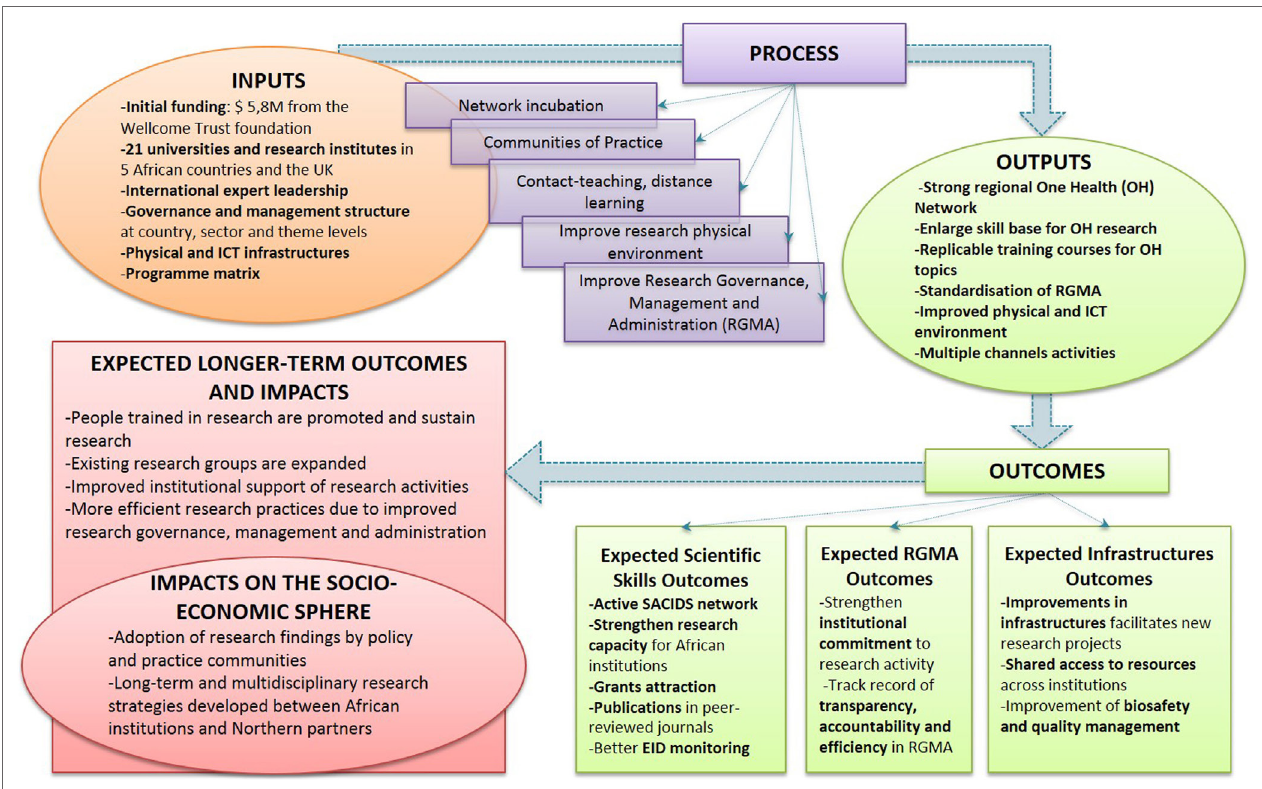
FigUre 5 | Theory of change of the Southern African Centre for Infectious Disease